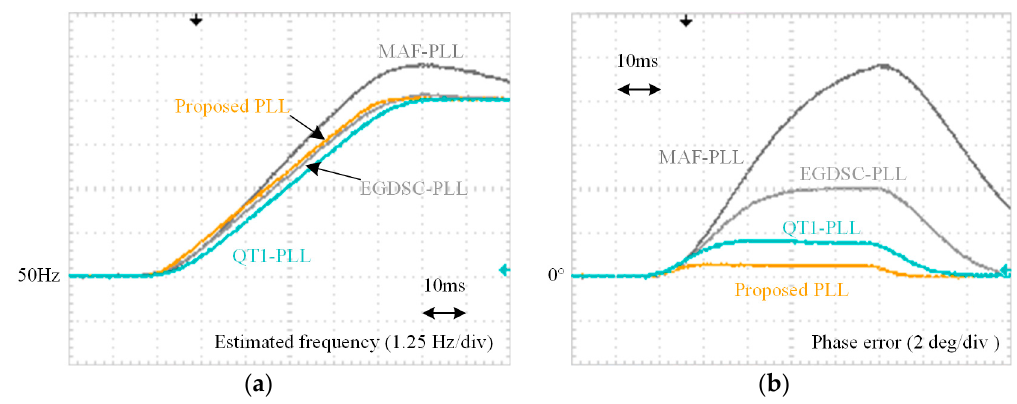
Figure 23. Grid voltages under + 5 Hz frequency step change conditions.